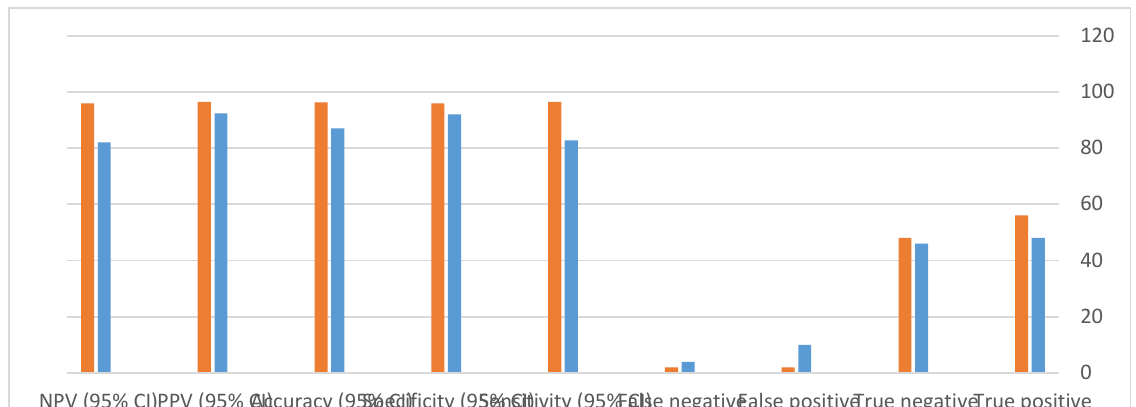
Figure 1. Diagnostic performance of blood-based RDT and urine-based RDT for detection of Plasmodium falciparum regarding blood film for Plasmodium falciparum malaria as a reference